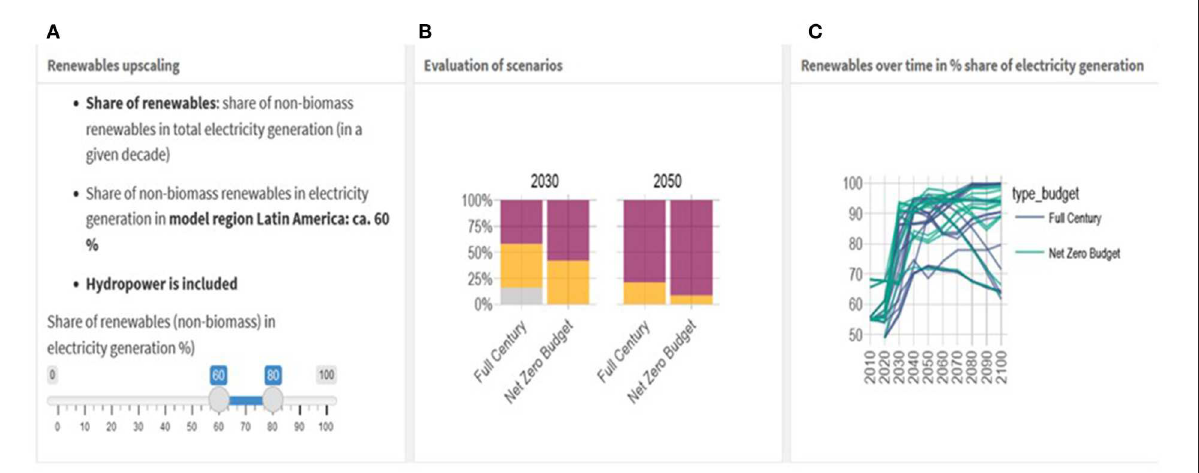
FIGURE5 A screenshot from the visual tool that was used for regional stakeholder workshops when the concept of feasibility was explored. The screenshot shows three panels: (A) Renewables upscaling; (B) Evaluation of scenarios; (C) Renewables over time in % share of electricity generation. Based on the work and concepts developed in Brutschin et al.